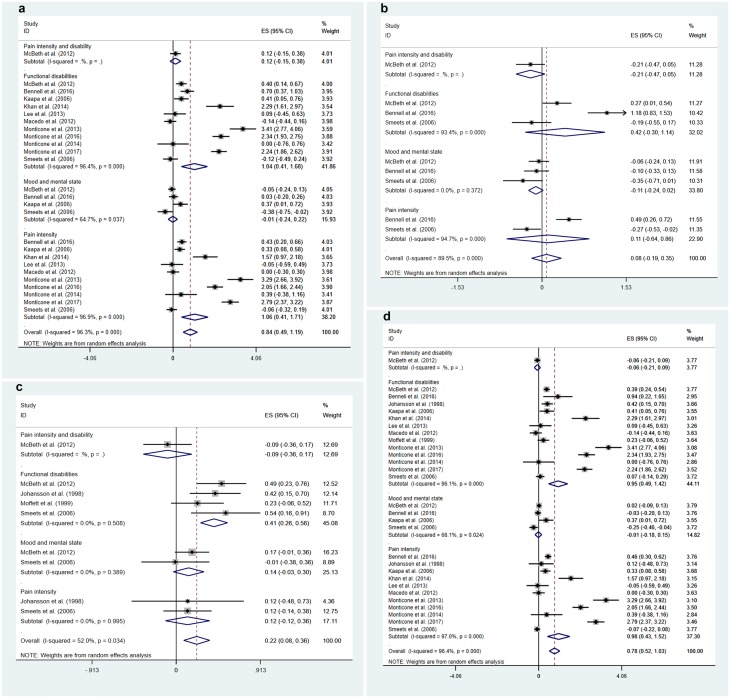
Forest plots for the effects of exercise cum cognitive-behavioural (CBT) intervention at post-intervention: (a) exercise alone as control, (b) CBT alone as control, (c) nonspecific control, and (d) all controls.